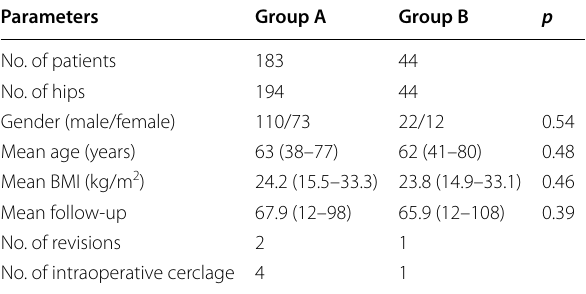
Table 5 Demographic and clinical